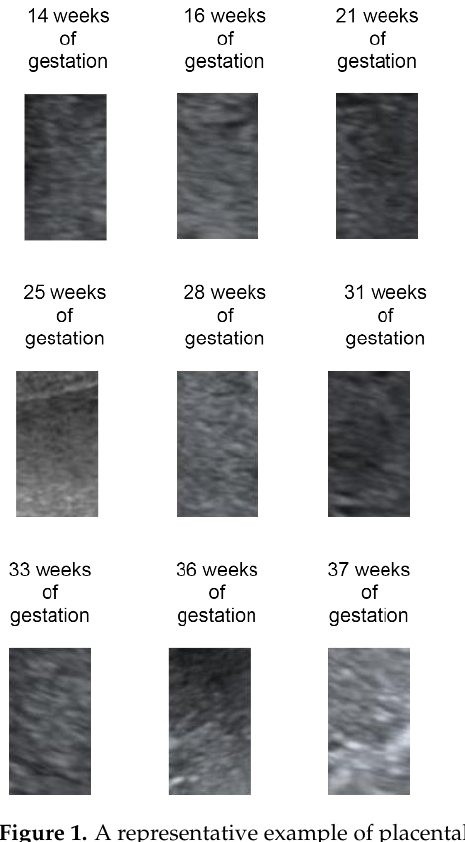
Figure 1. A representative example of placental evolution during pregnancy. The prevalence of preterm placental calcifications, whether early, before 32 weeks, or late, between 32 and 36 weeks of gestation, is reported with different numbers in many studies from the